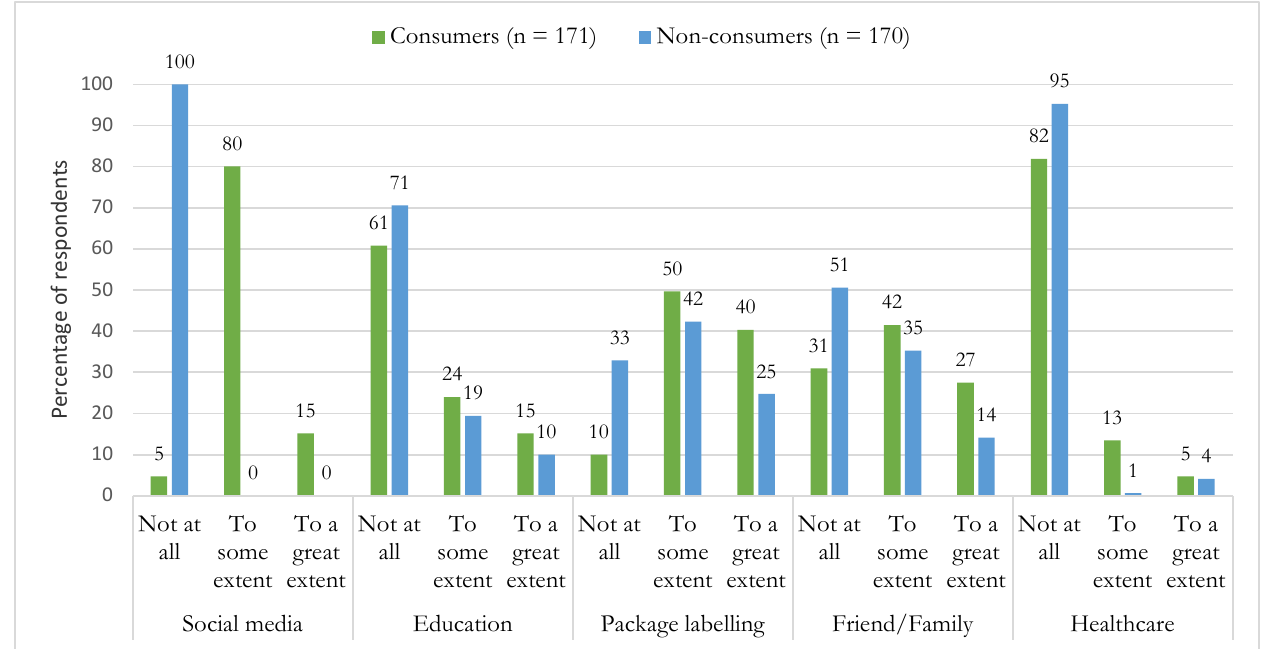
Figure 2. Usage of information sources regarding plant-based milk alternatives among Danish consumers and non-consumers. Results are presented as percentages.